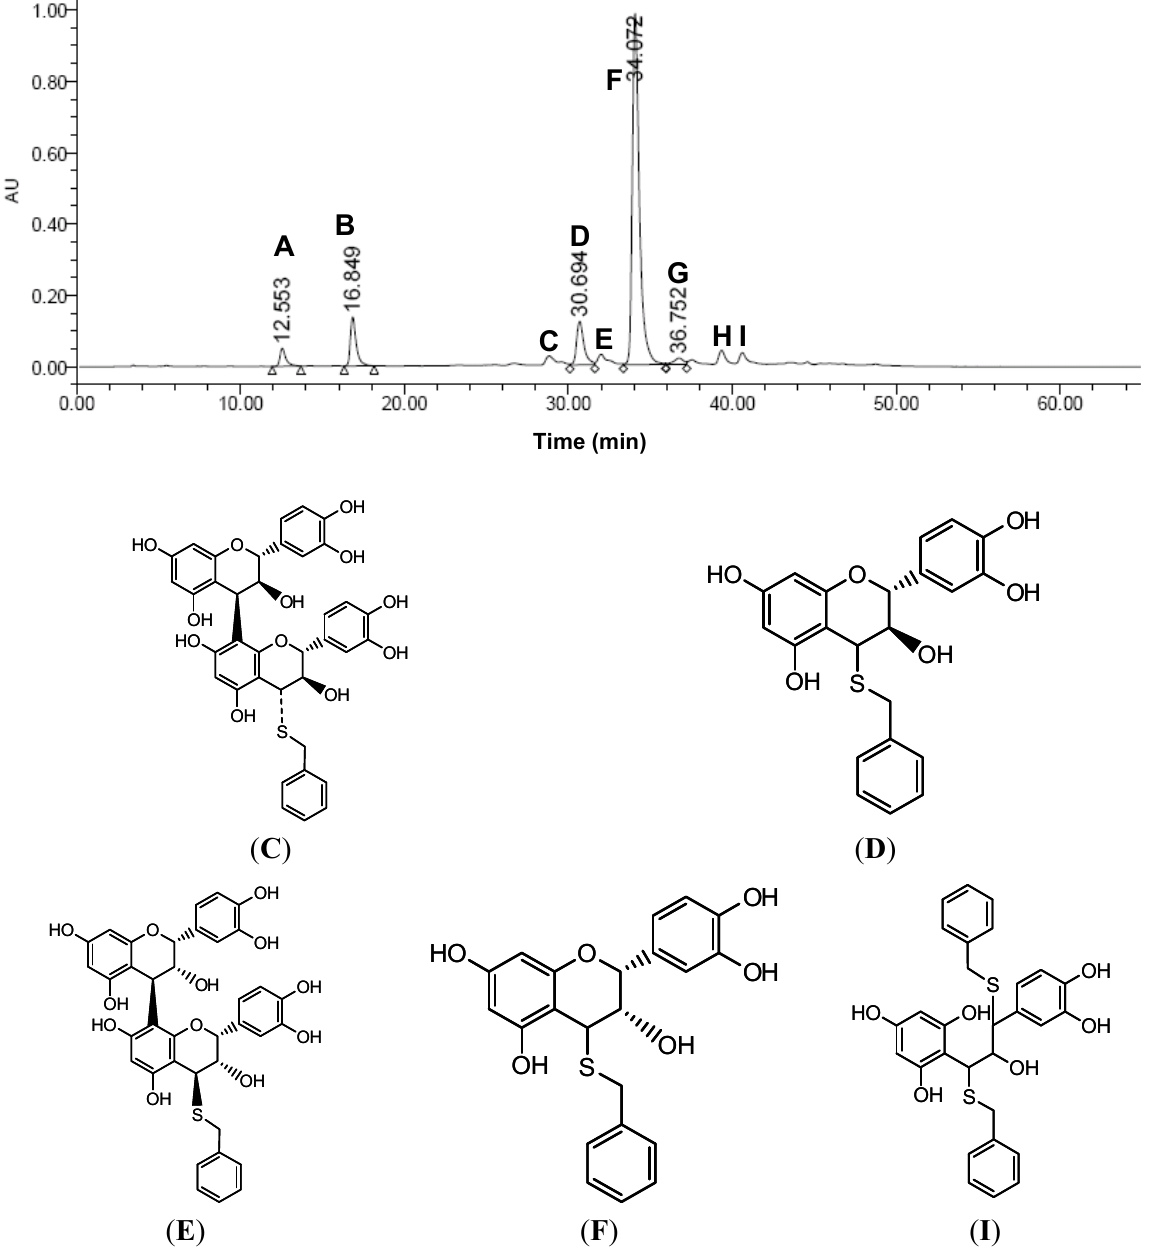
Figure 6. HPLC chromatogram (detector wavelength = 280 nm) of thiolytic products of durian seed OPCs by α -toluenethiol and the possible thiolytic products detected by LC-MS spectra. A, catechin; B, epicatechin; Structures of C, D, E, F, and I are shown in the Figure G is excess α -toluenethiol, H is an unknown